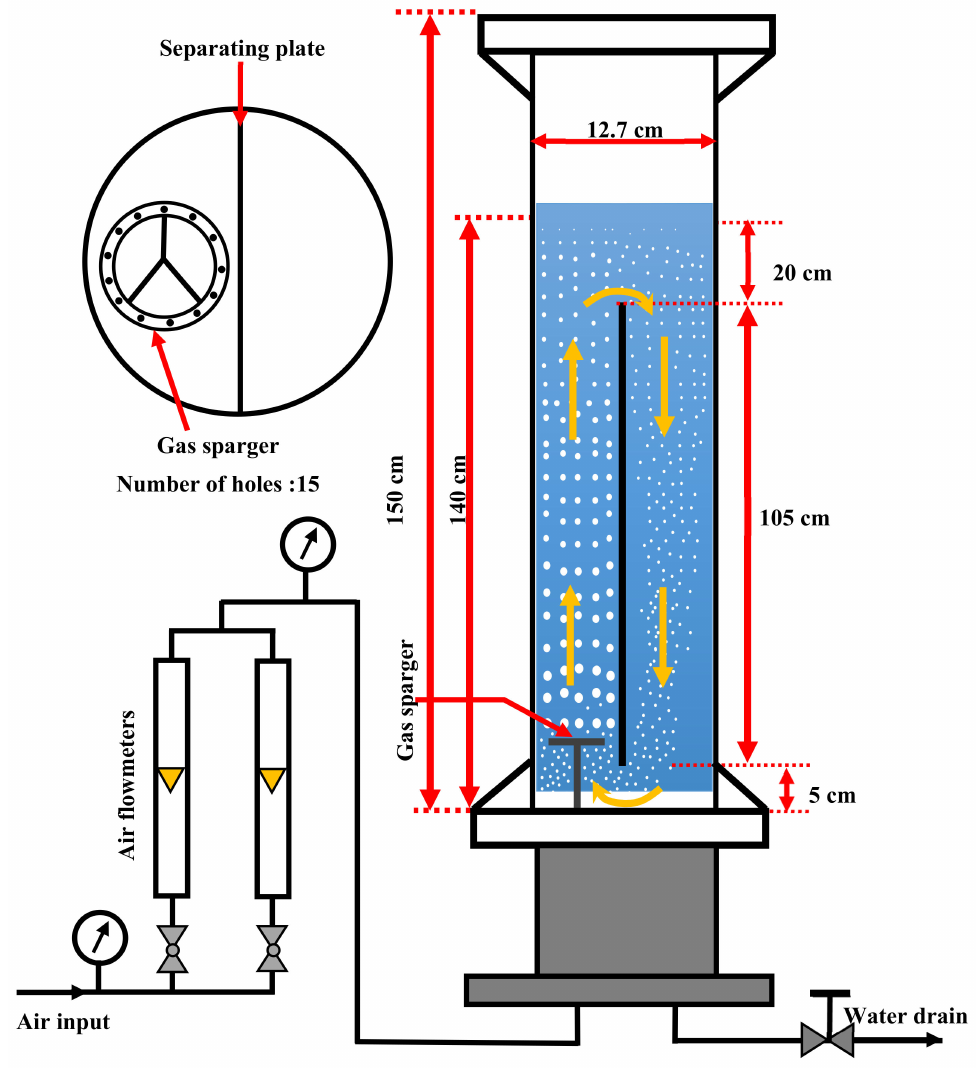
Figure 1. Schematic diagram of the split-plate airlift reactor with air flow